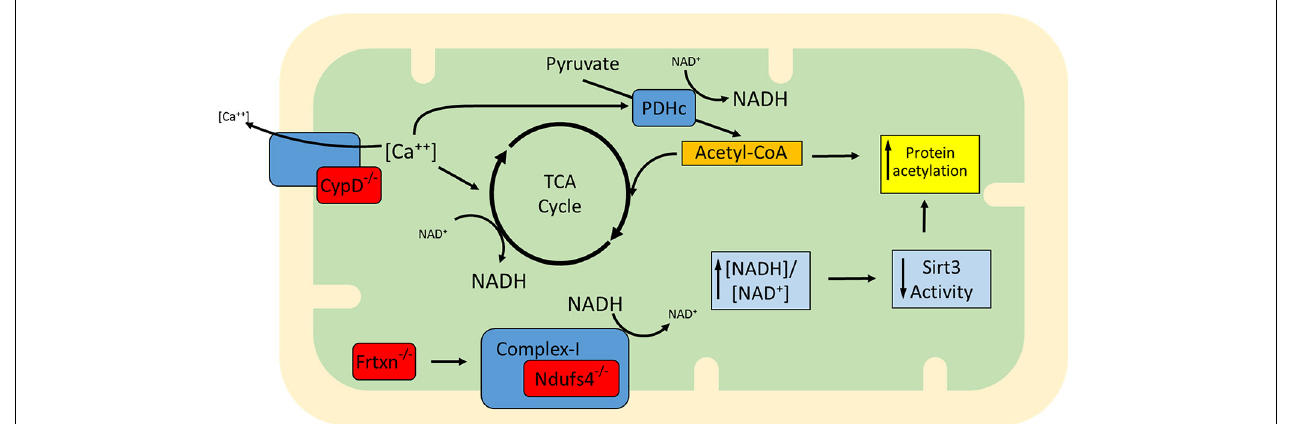
FIGURE 1 | Proposed model for the increased mitochondrial protein acetylation detected in the absence of Ndufs4, CypD, and frataxin (gene deficiencies shown in red). CypD facilitates Ca ++ efflux and when absent, mitochondria exhibit higher than normal [Ca ++ ]. This upregulates matrix dehydrogenases (e.g., TCA cycle dehydrogenases and PDH). Dehydrogenase activation enhances generation of NADH, altering the balance to higher ratios of [NADH:NAD + ]. Complex I normally converts NADH back to NAD + but in the absence of Ndufs4 this conversion is blocked. Defects in complex I activity